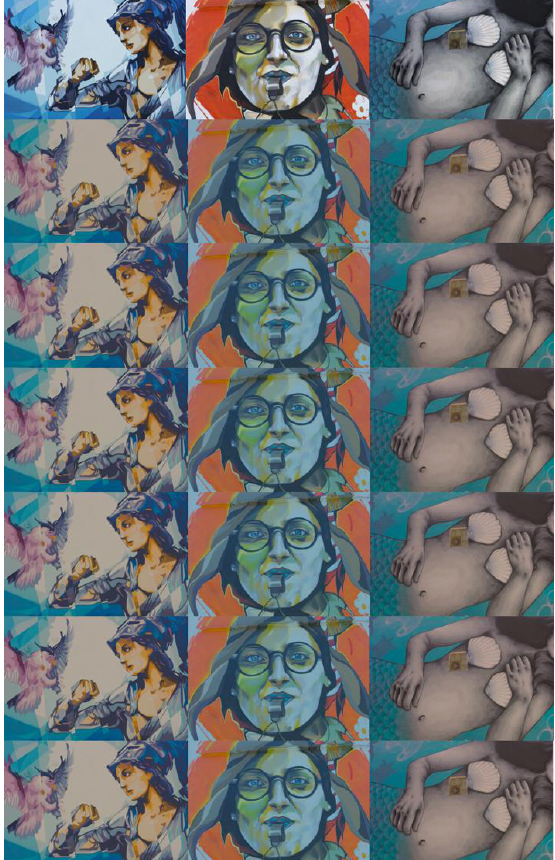
Figure 6: Athena, redWhistle and mermaid graffities. From top to bottom: The final I(ref), I(demo)AAHD, I(demo)AHD, I(demo)PPG, I(demo)DCB, I(demo)DHT and